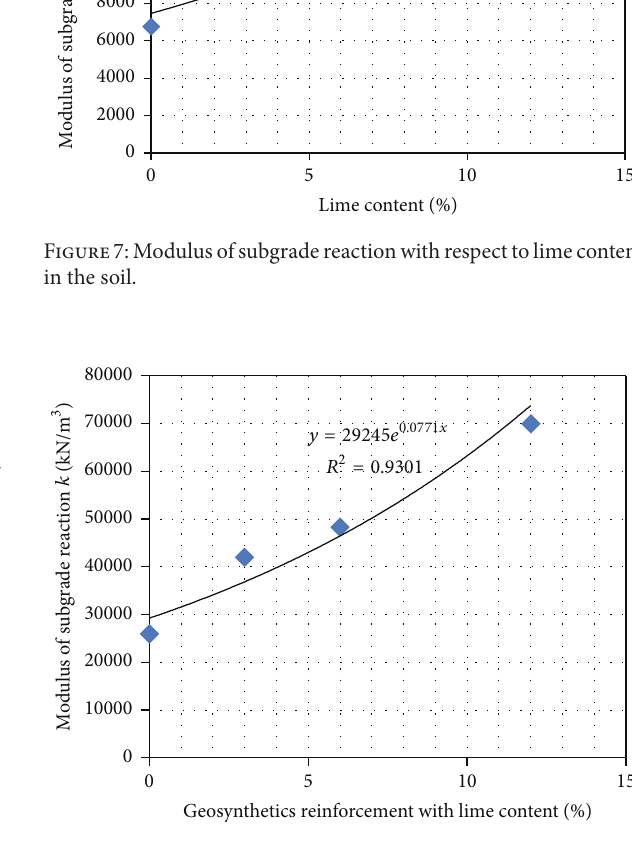
Figure 8: Modulus of subgrade reaction with respect to geosynthet- ics (geocell + geotextile) reinforcement with lime content in the